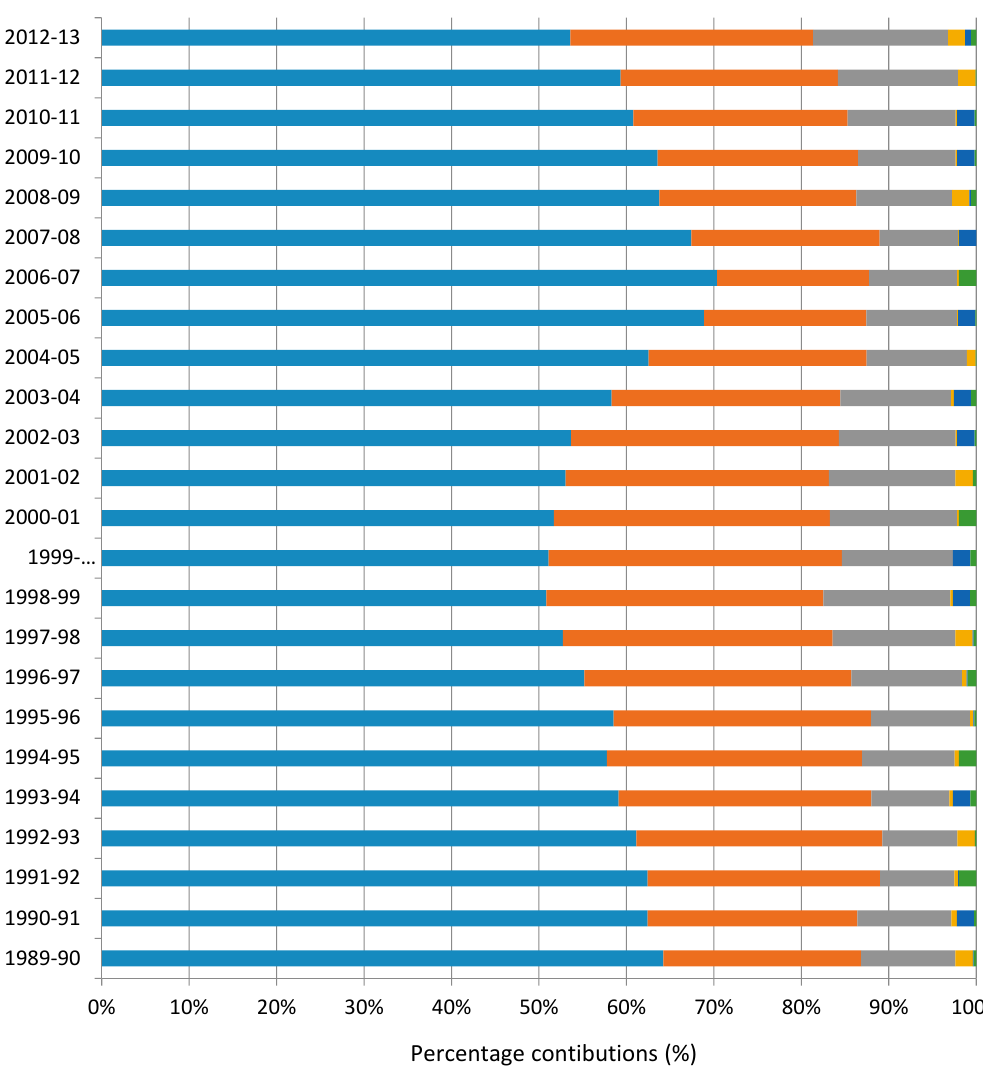
Figure 8. Percentage contributions in data uncertainty from 1989 to 2013.